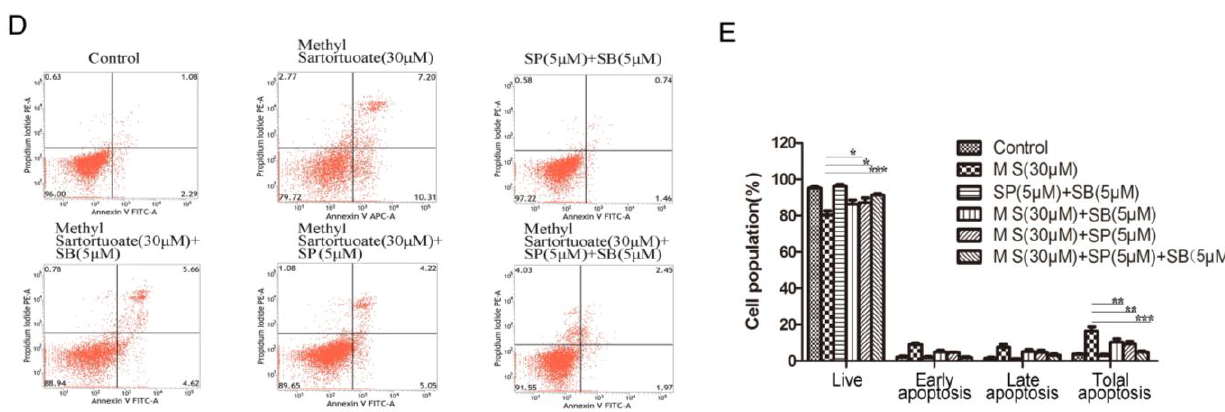
Figure 5. Methyl Sartortuoate induced LoVo cell apoptosis by activated JNK and P38 pathway. ( A – C ) Methyl Sartortuoate activated p-p38 and p-JNK in LoVo and RKO